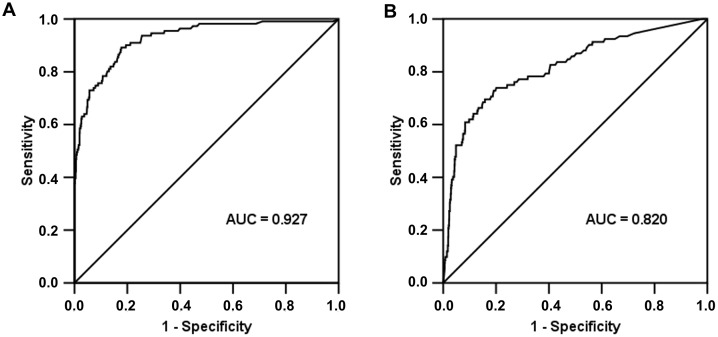
ROC curves for SeptiFast and blood cultures results according to different cut-off of PCT.SeptiFast: Area Under the Curve (AUC) = 0.927; 95% confidence interval (CI): 0.899–0.955, p<0.0001 (panel A). Blood culture: AUC = 0.820; 95% CI: 0.769–0.870, p>0.0001 (panel B).